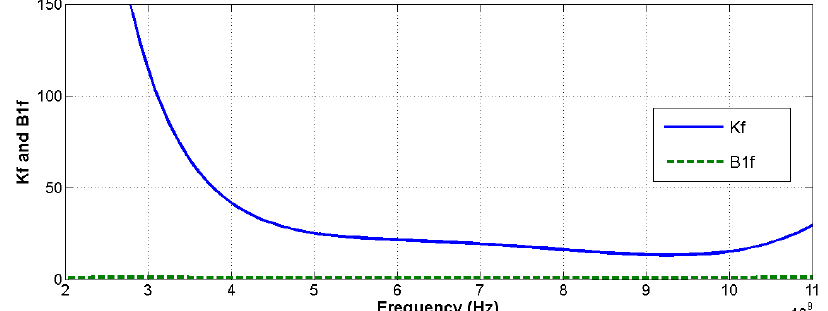
Figure 15. K f and ∆ ( B 1 f ) simulation results.